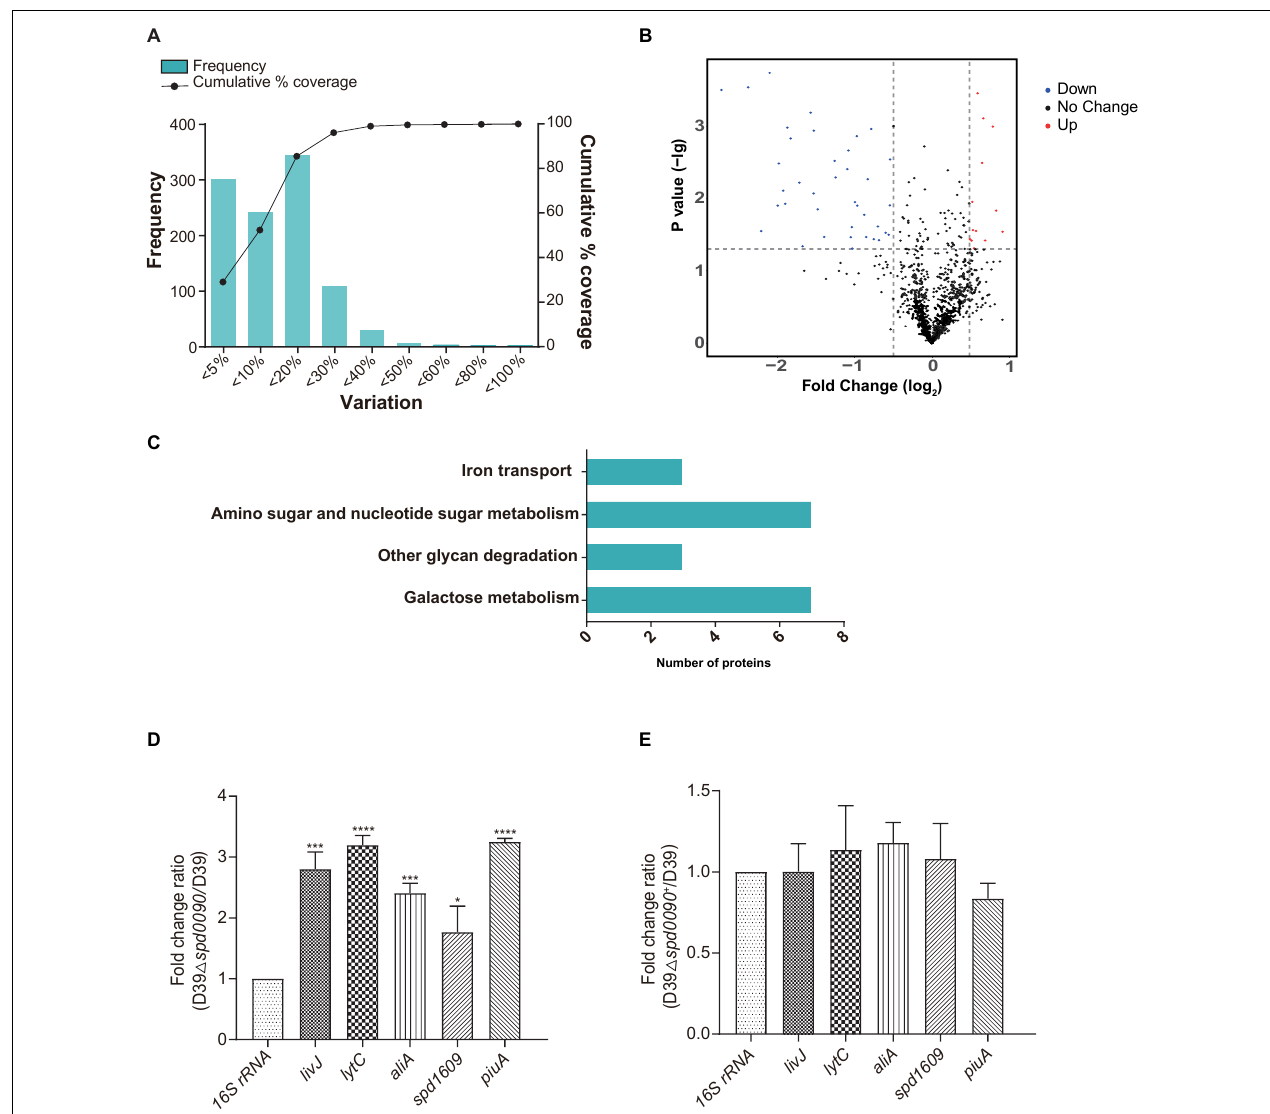
FIGURE 7 | The results of iTRAQ-based proteomics quantitative analysis. (A) Distribution of biological variables in two replicates. (B) The volcano map of the differentially expressed proteins. Each dot represents the average level of individual proteins obtained from two independent biological experiments. The red and blue dots were recognized as differentially expressed proteins according to the fold change, which was more than 1.4-fold or less than 0.71-fold, and p < 0.05. (C) Enriched pathway for differentially expressed proteins. (D,E) The relative mRNA expression levels of genes involved in virulence regulation were determined by RT-qPCR. All results represent the relative expression levels of strain D39 (cid:49) spd0090 vs. D39 strain or D39 (cid:49) spd0090 + strain vs. D39 strain. The results as the mean value ( ± SEM) from three independent biological experiments. Data were compared to 16S rRNA as determined by the Student’s t -test analysis (* indicates p < 0.05, ** indicates p < 0.01, *** indicates p < 0.001 and **** indicates p < 0.0001).